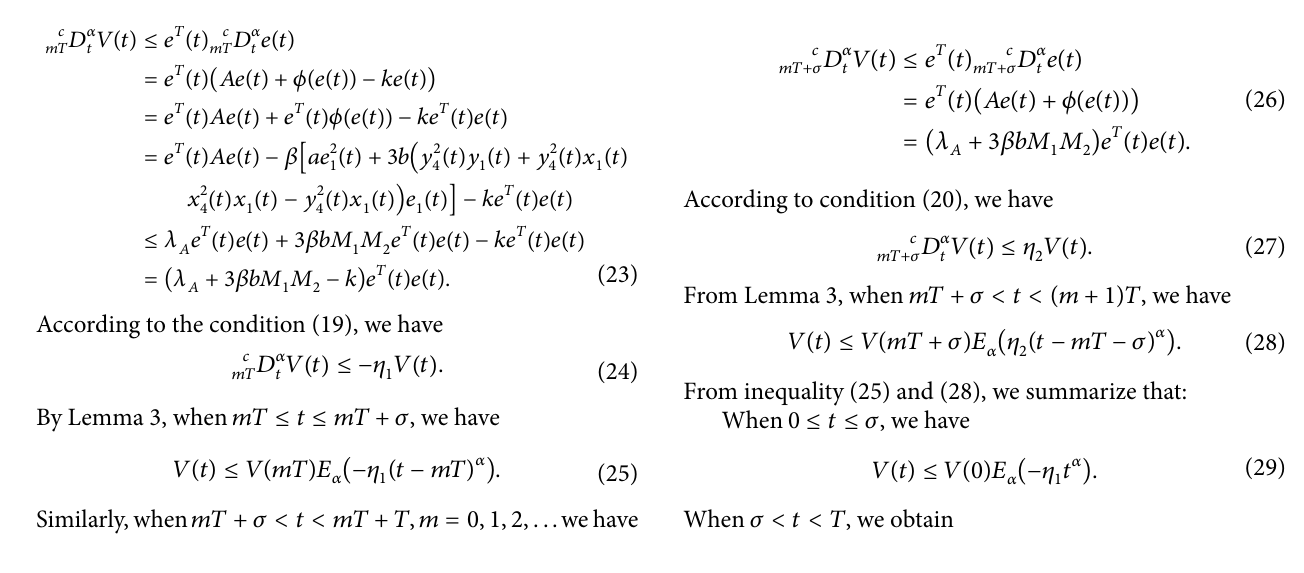
, , , , , and 𝜎 = 0.8 , (a) 𝜂 1 = 30 𝜂 2 = 34 𝑘 = 33 𝑇 = 1